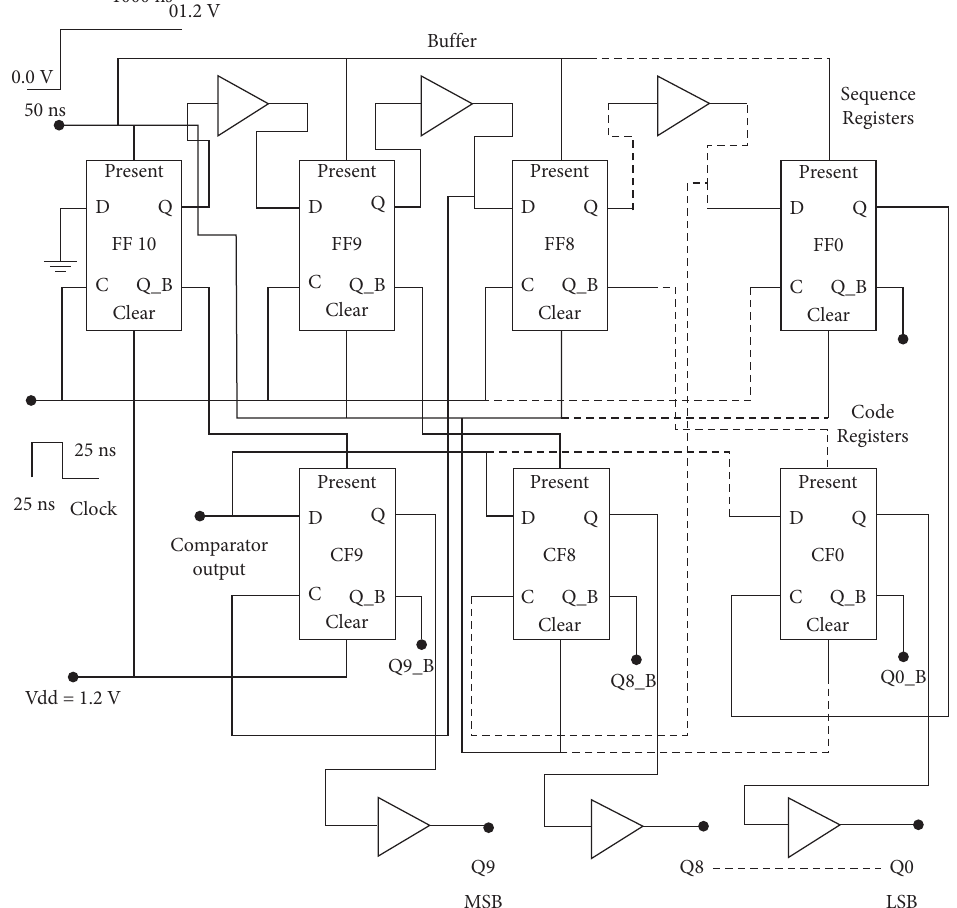
Figure 36: Schematic of the sequence/code register SAR logic